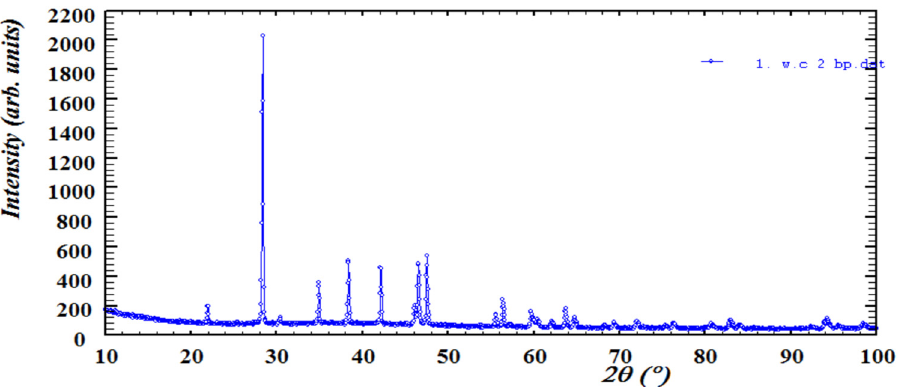
Figure 5: Experimental di ff ractogram of deposited precipitate stored for 3 days.